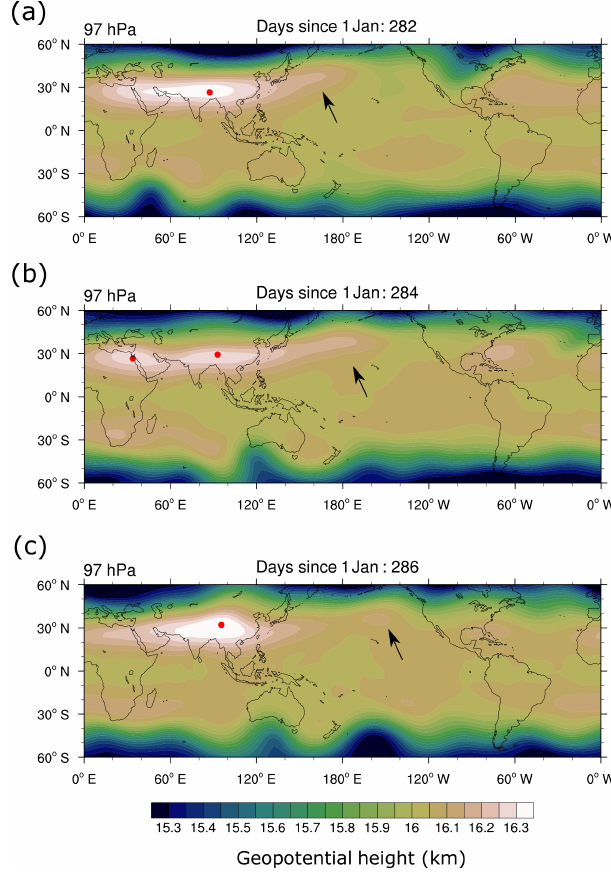
Figure 15. Evolution of geopotential height at ∼ 100hPa showing an example of a splitting event and an eastward shedding event over a 5d period. Red dots indicate the approximate positions of the an- ticyclone centers, while arrows highlight the eddy shedding